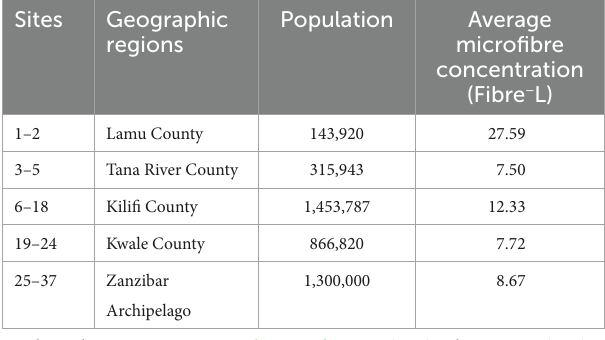
TABLE 2 Population of geographic regions of sampled